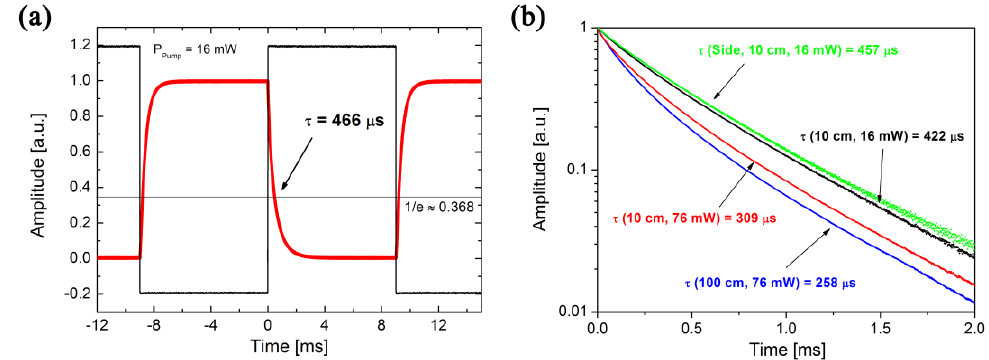
Figure 6. ( a ) Measured oscilloscope output and ( b ) fluorescence decay curves for different lengths and pump powers with the resulting lifetime values for the SD optical fiber fiber (green curve—side detection; black, red, and blue curve—longitudinal detection) [23].